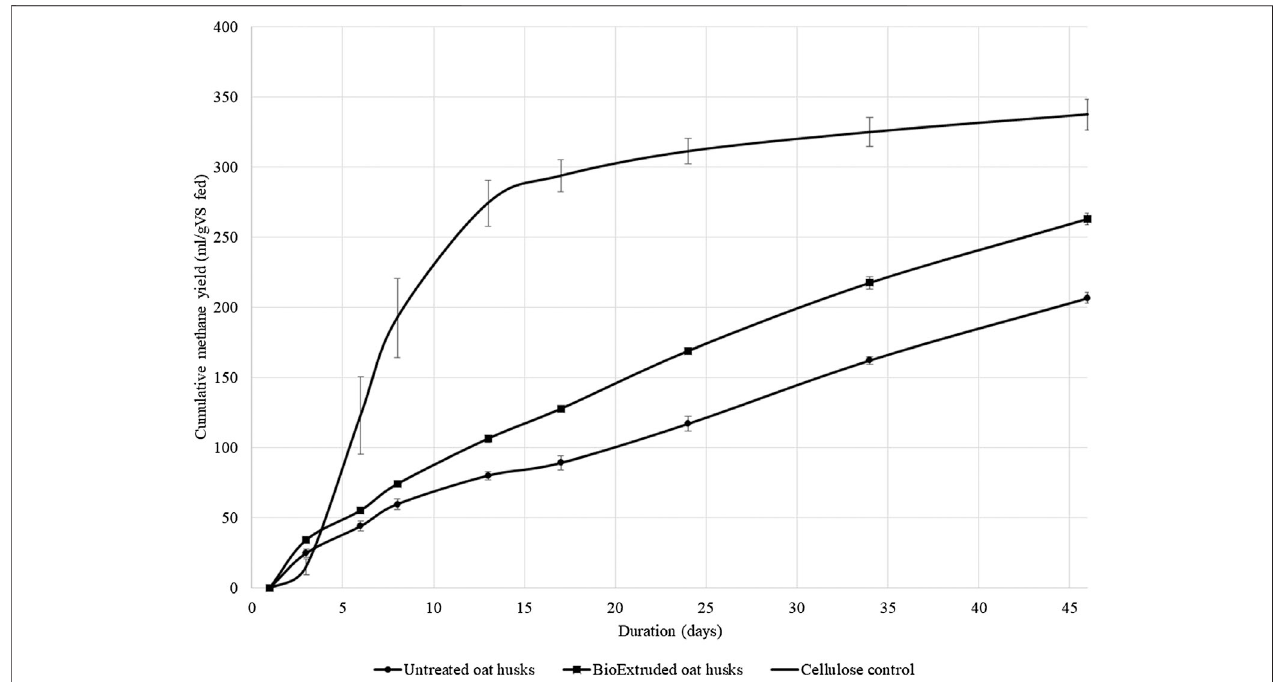
FIGURE 2 | The mean cumulative methane yield from oat husks (untreated and pre-treated via the BioExtruder) and cellulose controls. Digestate blank assay methane yields were subtracted from both treatment yields.